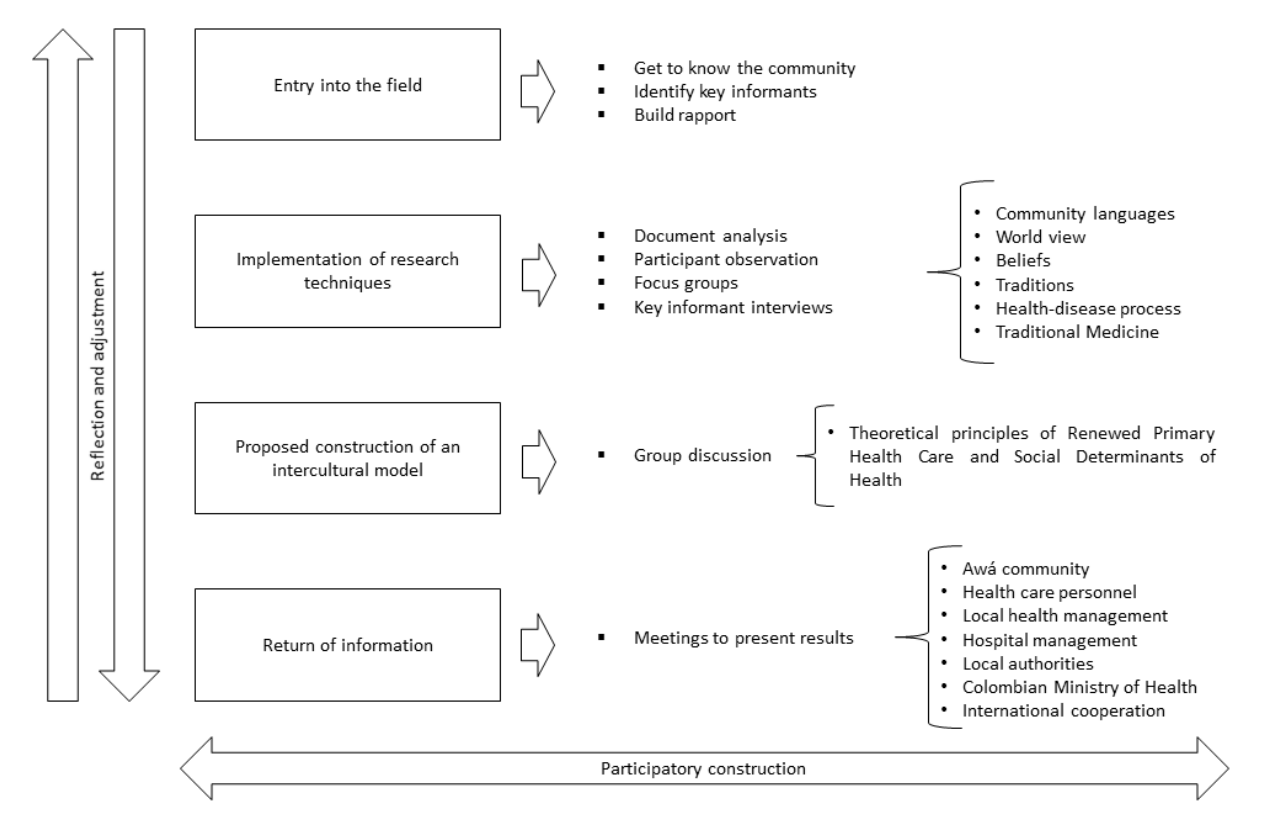
Figure 1. Research procedure.